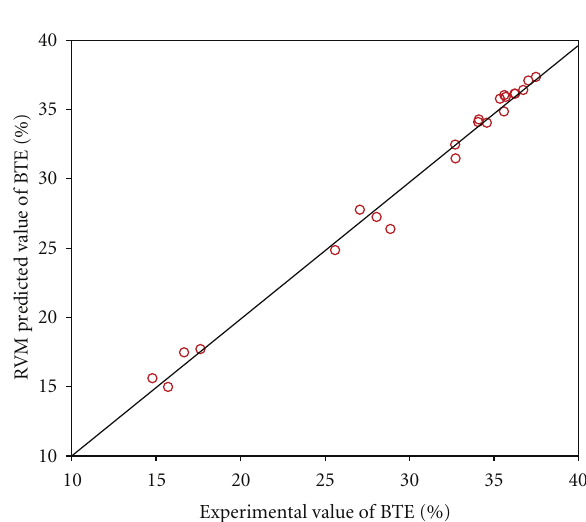
Figure 4: Comparison between RVM predicted values and the cor- responding actual values for